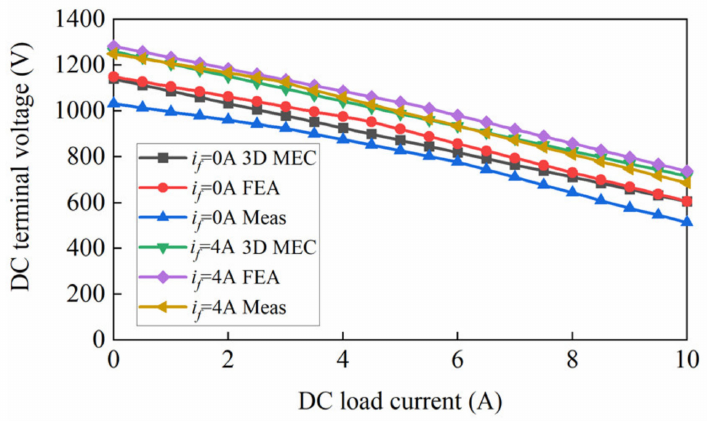
Figure 15. External characteristics.